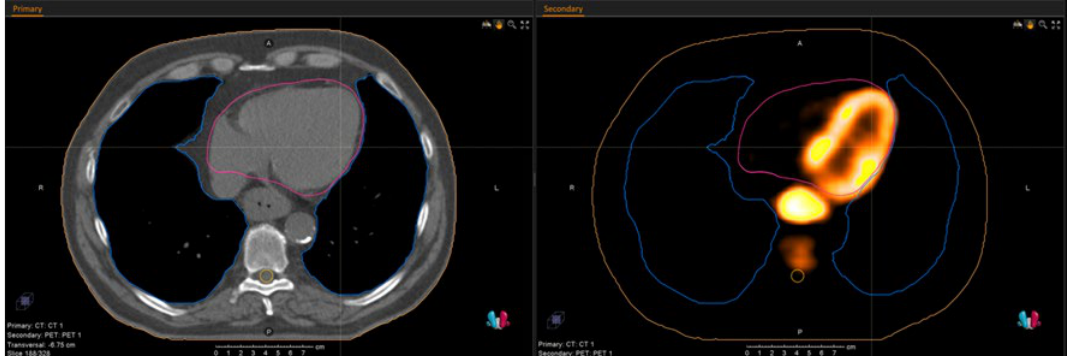
Figure 1. Transversal layer of pretherapeutic CT (left) and 18F-FDG-PET (right); blue: lung contour; pink: heart contour.